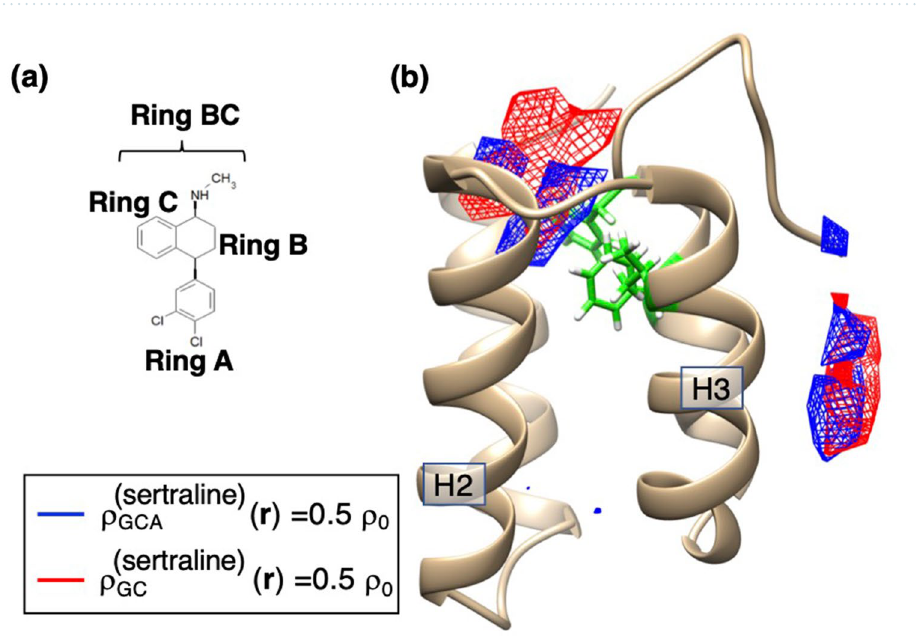
Figure 3. Radial distribution functions (RDFs) p (cid:31) r YN3–mSin3B ( s = YN3), and ( c ) acitretin–mSin3B systems ( s = acitretin). Three RDFs p (cid:31) r p (cid:31) r ( s ) Phe 96 (cid:30) are shown by different colors as indicated in insets of panels. See Supplementary Section 6 for procedure to calculate RDF.